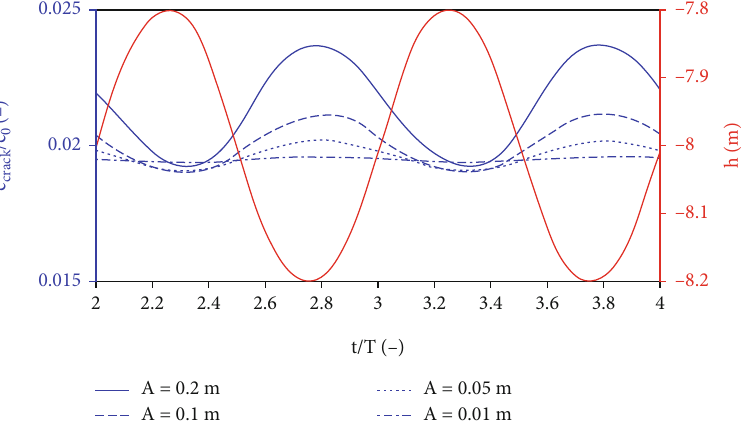
Figure 9: The variation of normalized gaseous TCE concentration at the crack for the cases with T =one day and di ff erent fl uctuation amplitudes ( A = 0 : 01 m, 0 : 05m, 0 : 1m, and 0 : 2m ). The variation of the groundwater table level in the case with A = 0 : 2 m is also